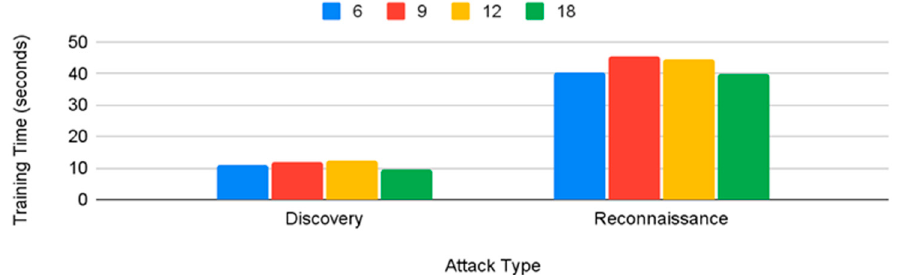
Figure 11. Number of attributes vs. training times for all algorithms.